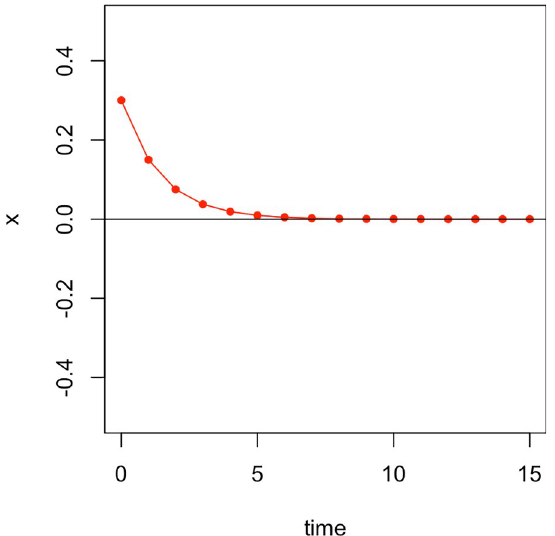
Fig 4. The evolution of the states of the system given by the differential equation in (1) starting with x 0 = 0.3.